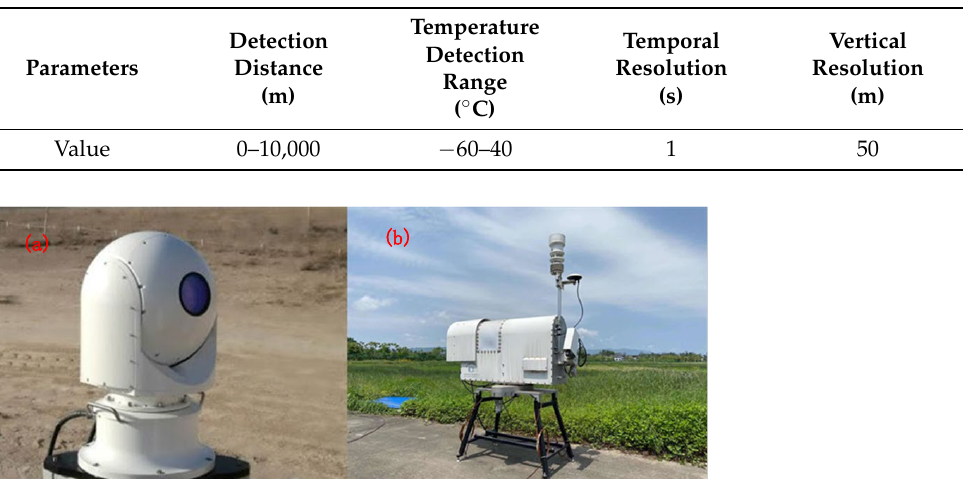
Figure 2. Experimental scenario of ( a ) the pulsed coherent Doppler lidar and ( b ) the microwave radiometer.